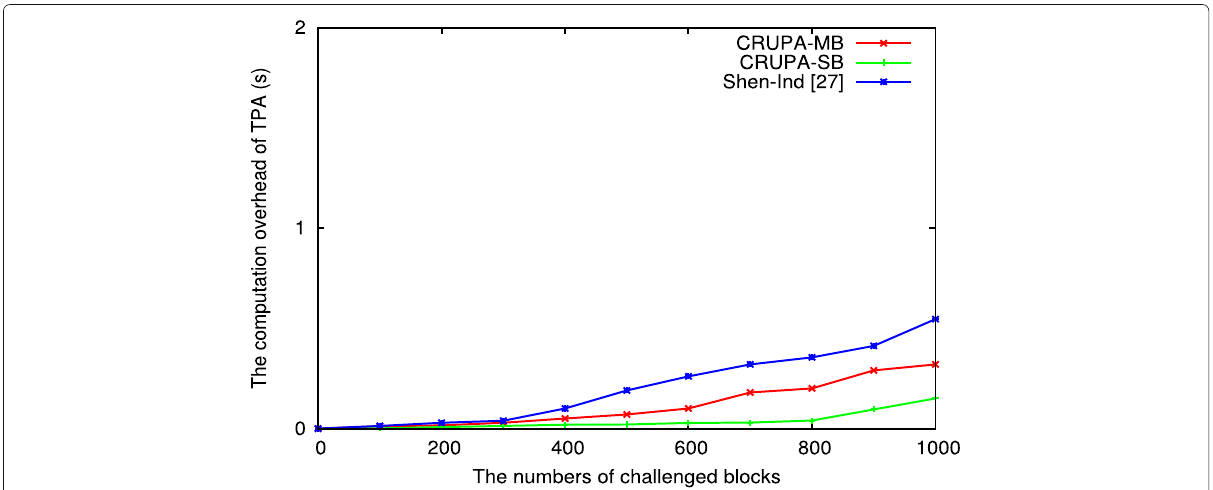
Fig. 8 Computation overhead of TPA during challenge generation